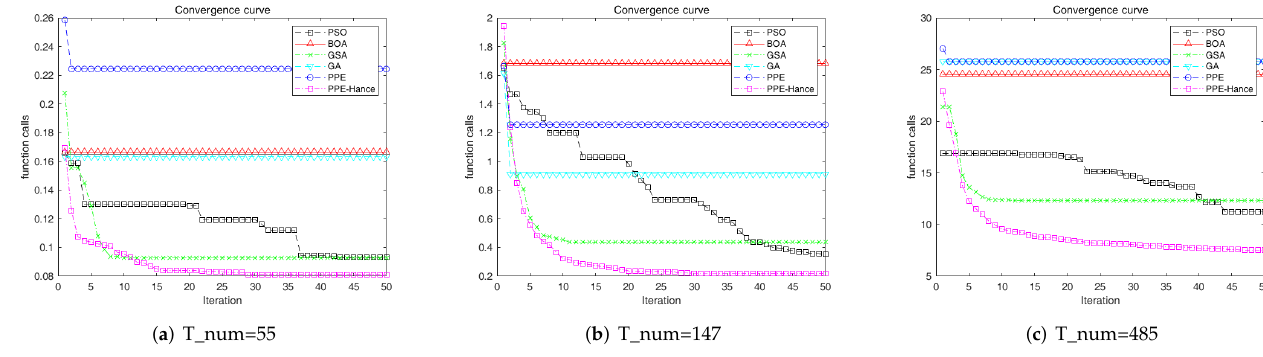
Figure 2. Performance comparison of algorithms in a heterogeneous environment.